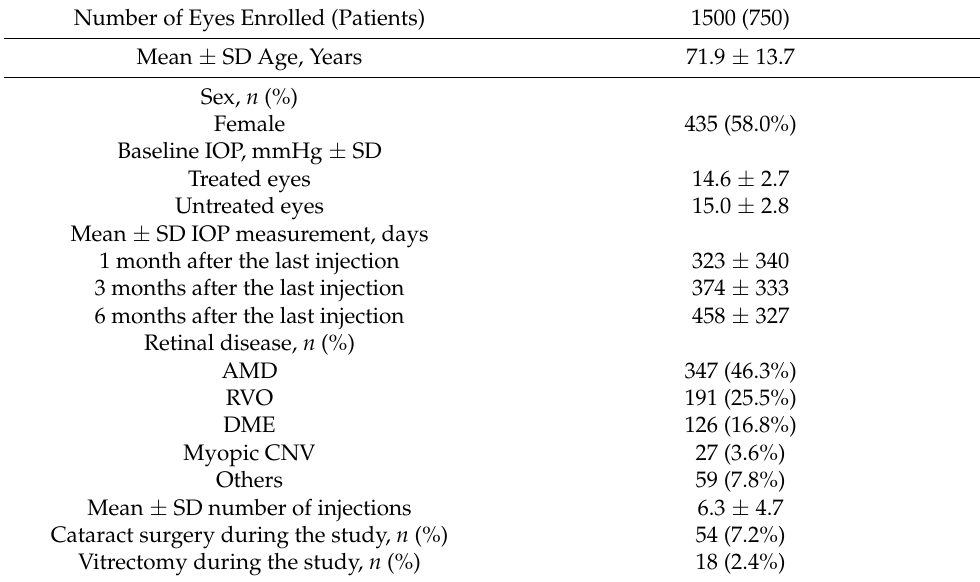
Table 1. Baseline characteristics of patients injected with anti-vascular endothelial growth factor agents.